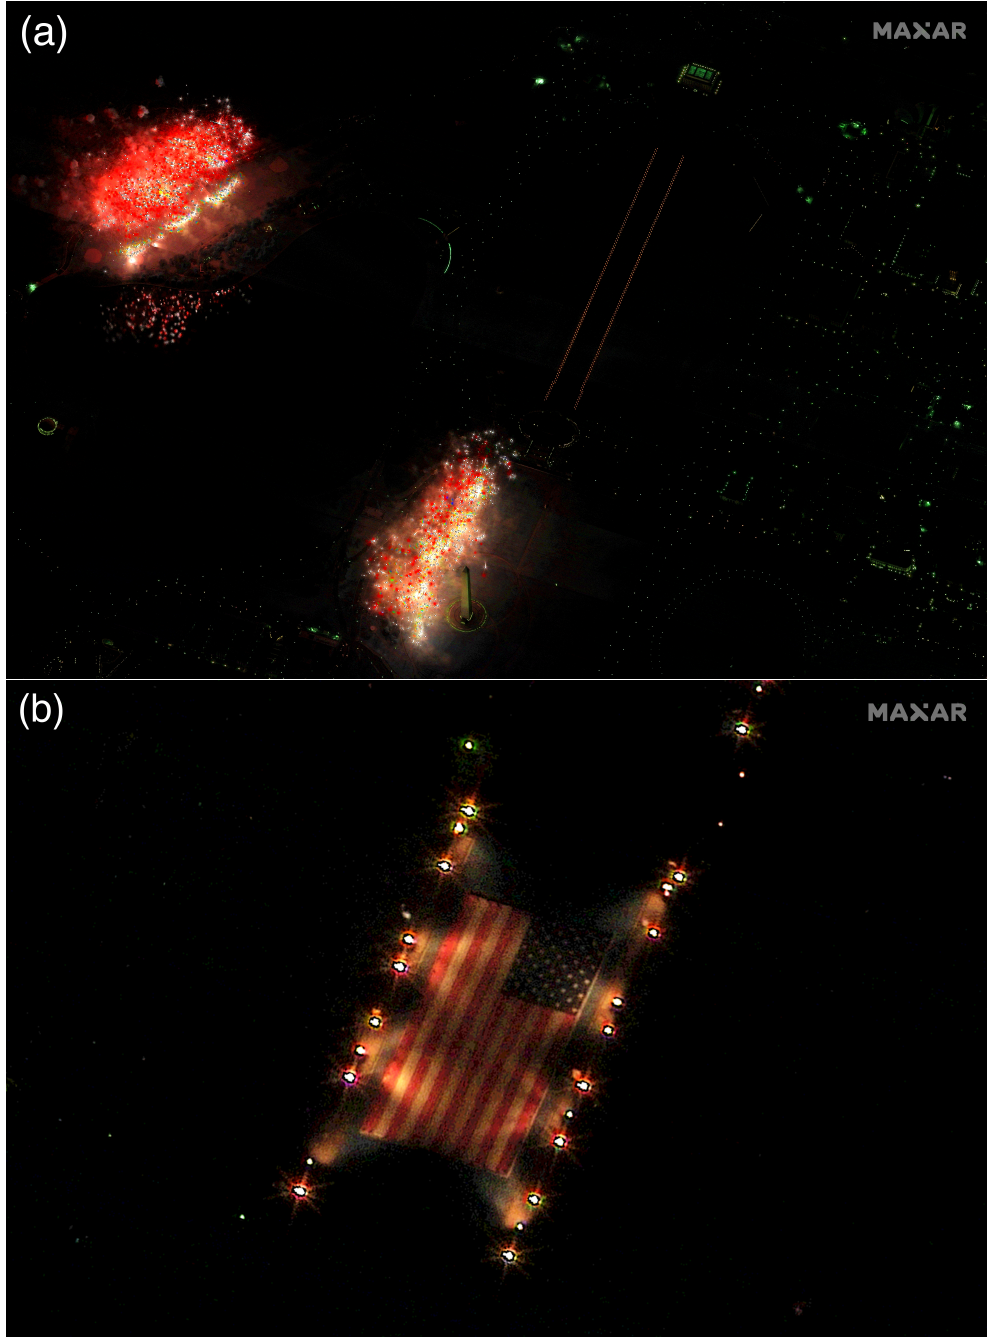
Figure 2. True-color images of the National Mall and vicinity in Washington, U.S., obtained by the Worldview-3 satellite on the night of 20 January 2021. The spatial resolution of this commercial satellite imagery is approximately 1.3 m per pixel. ( a ) The brightest parts of this image show a fireworks display held in honor of that day’s U.S. Presidential Inauguration. ( b ) A detailed view of a large American flag displayed on the Mall for the inauguration. Satellite images ©2021 Maxar Technologies, used with